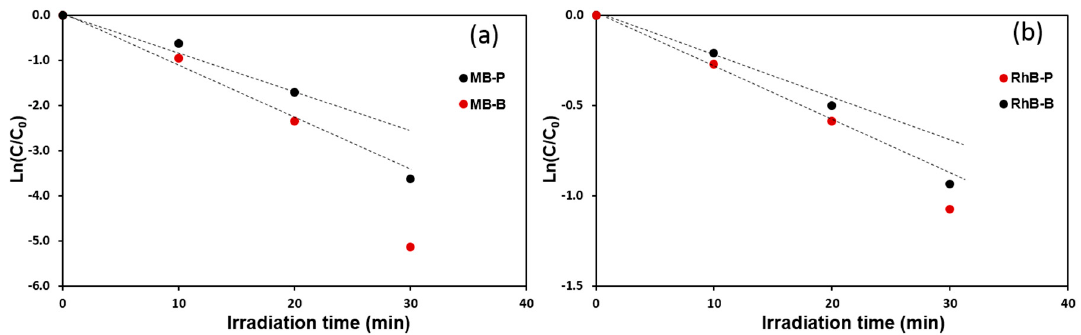
Figure 8. The plot of C/C 0 vs. time of irradiation for Bi 2 WO 6 films ( a ) for MB dye and ( b ) for RhB dye.